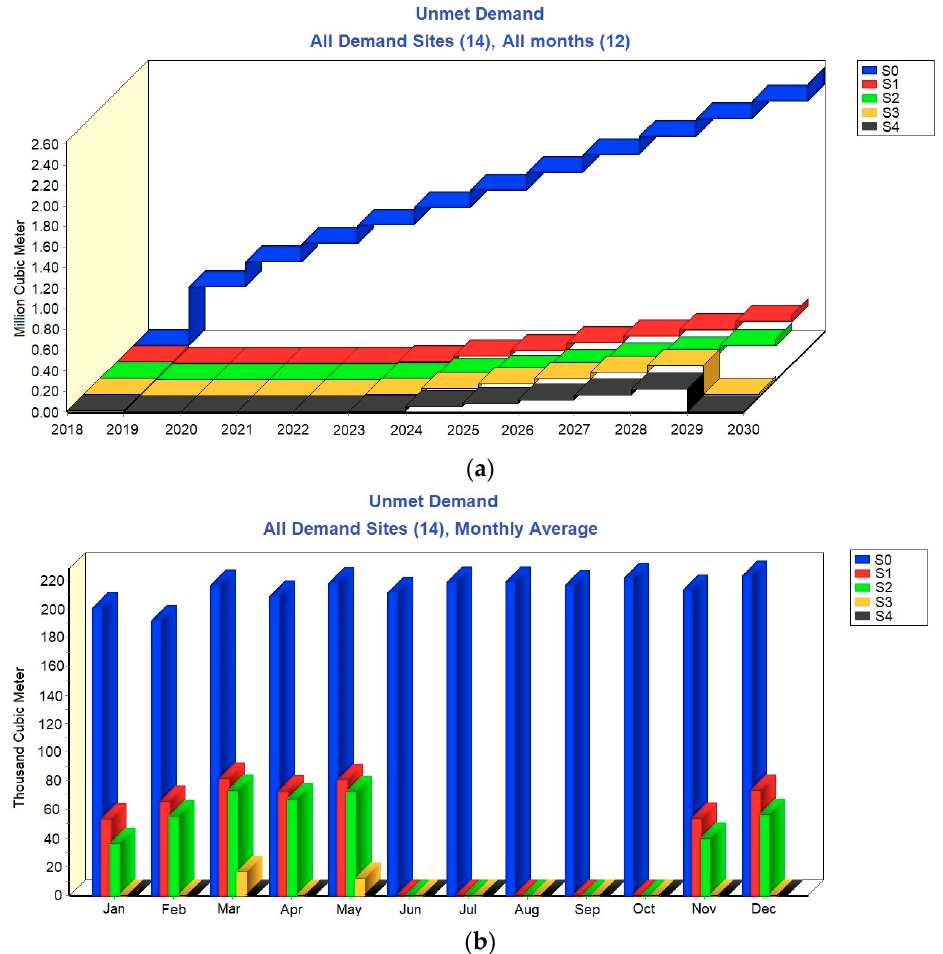
Figure 8. Unmet demand in Con Dao Island under S0, S1, S2, S3, S4 scenarios: ( a ) by year; ( b ) by monthly average.